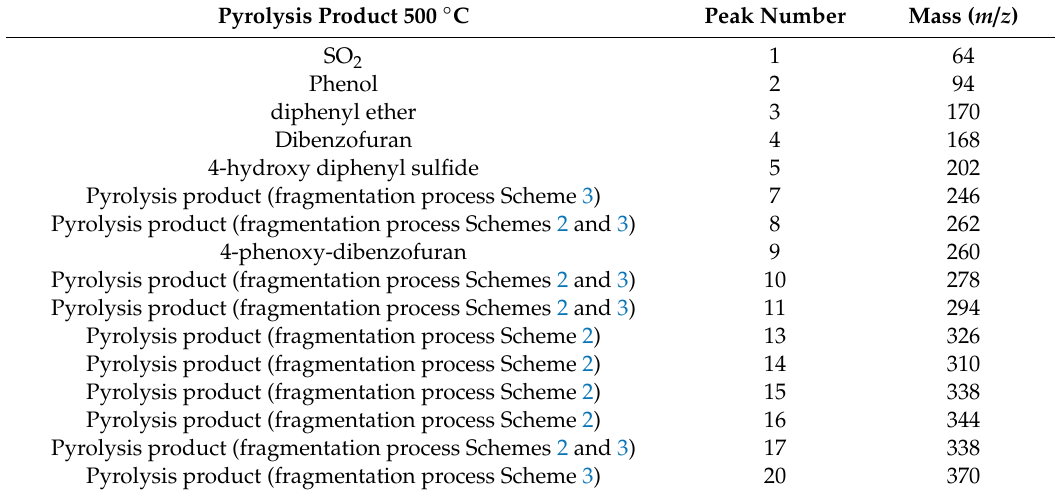
Table 3. Identification of the product of pyrolysis formed at 500 ◦